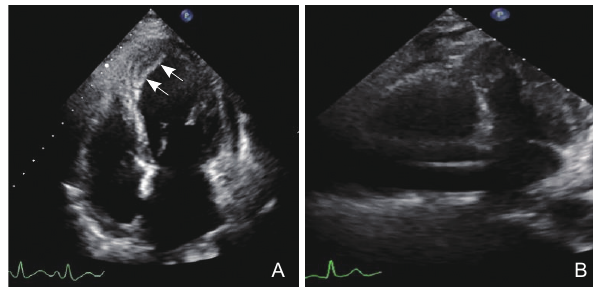
Figure 14 COVID-19 with cardiac abnormalities. (A) A 45-year-old female COVID-19 patient (positive nucleic acid test, D-dimer: 3.39μg / mL,TNI: 9889.4 ng / L, BNP: 632 pg / mL). Left ventricular thrombosis formation on the apical four-chamber view (indicated by arrows); (B) A 69-year-old male COVID-19 patient (positive nucleic acid test, respiratory failure, D-dimer: 6.82 μg/mL, BNP:632 pg/mL). Echocardiogram showed significantly enlarged right heart on the apical four-chamber right ventricle- focused view.